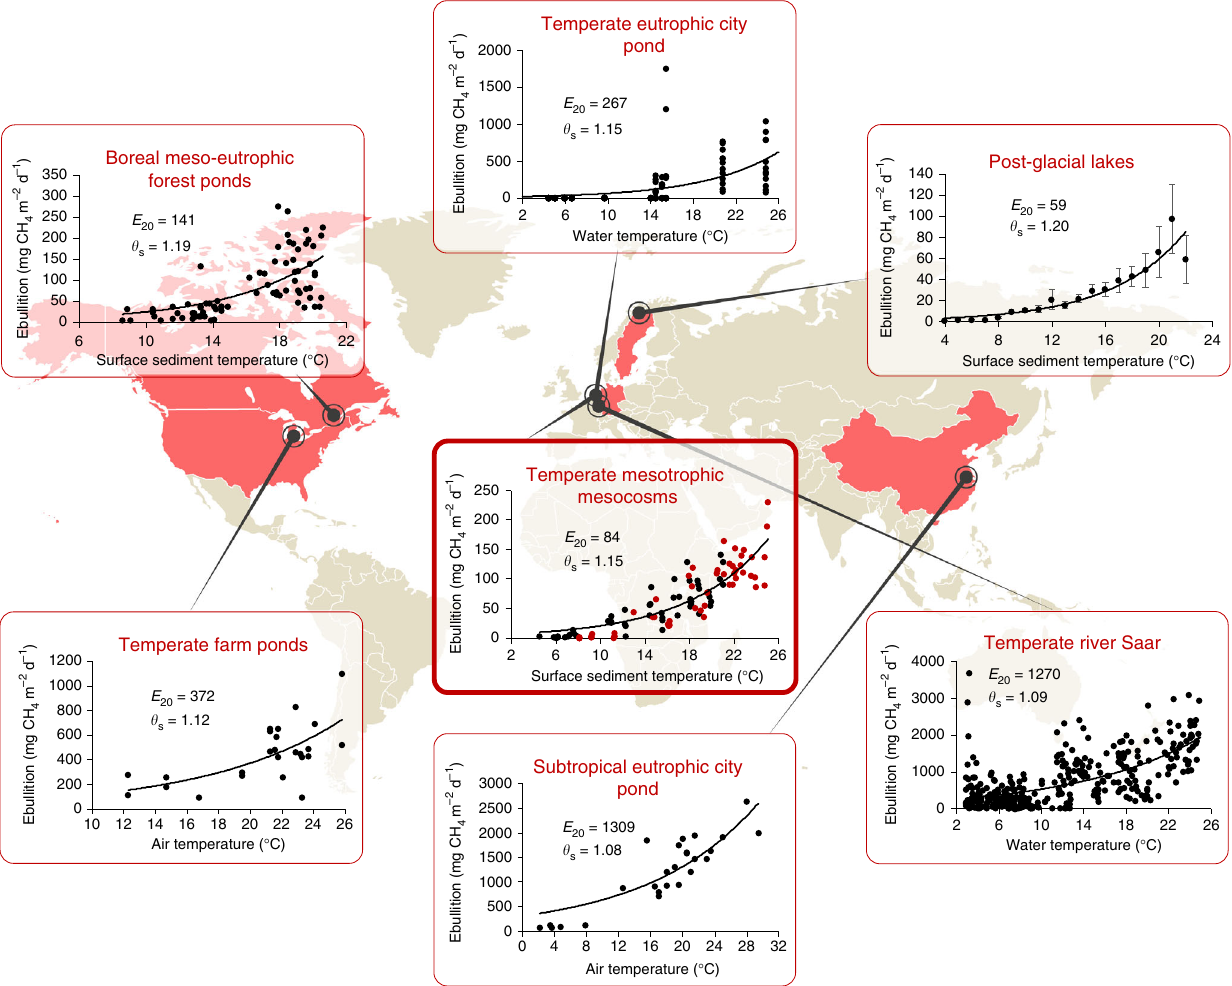
Fig. 1 Relationships between temperature and CH 4 ebullition found in different types of freshwater ecosystems. Regression lines represent the fi tted modi fi ed Arrhenius expression; see Eq. (2). Error bars denote 95% con fi dence intervals (Post-glacial lakes). Graphs with thin border lines represent fi eld data. Graph with thick border line represents experimental data. For the latter, black and red dots represent control and warm treatment, respectively. For studies with multiple data sets, the location with the longest data record is depicted. See Table 1 and Supplementary Table 1 for info on all data sets. Details on the origin and acquisition of data are described in the “ Methods ”